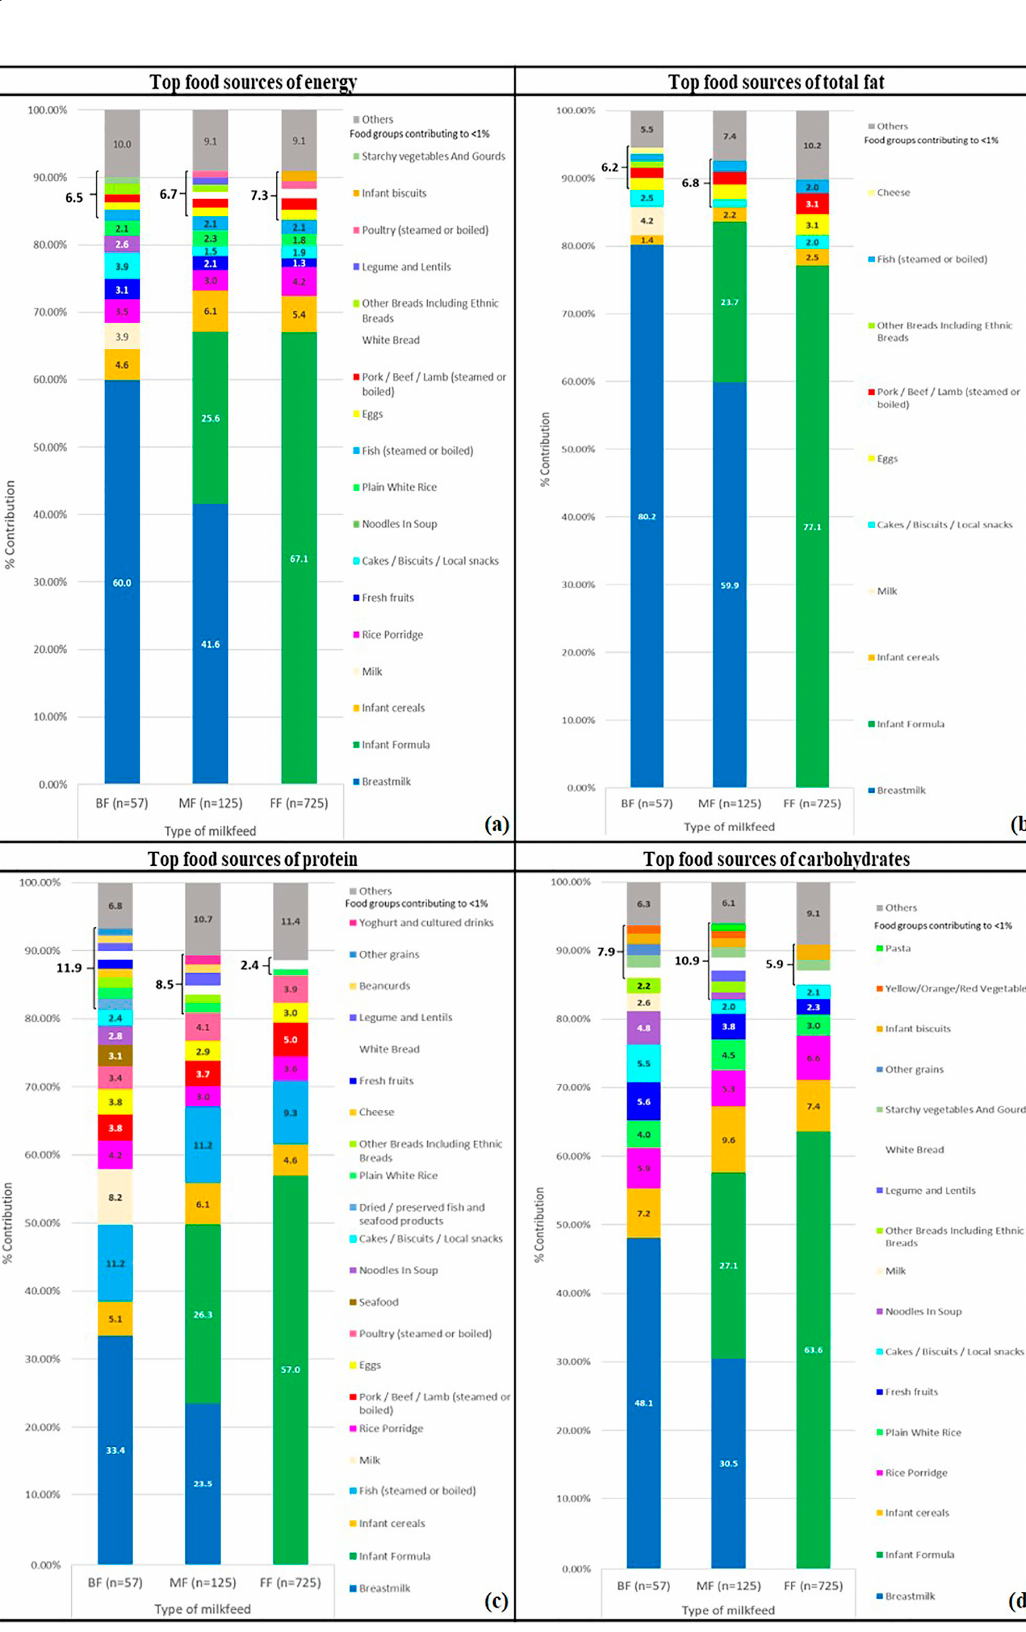
Figure 2. Cross ‐ sectional analyses of top food sources of ( a ) energy, ( b ) total fat, ( c ) protein and ( d ) carbohydrate of BF, MF and FF Growing Up in Singapore Towards healthy Outcomes (GUSTO) infants at 12 months of age.